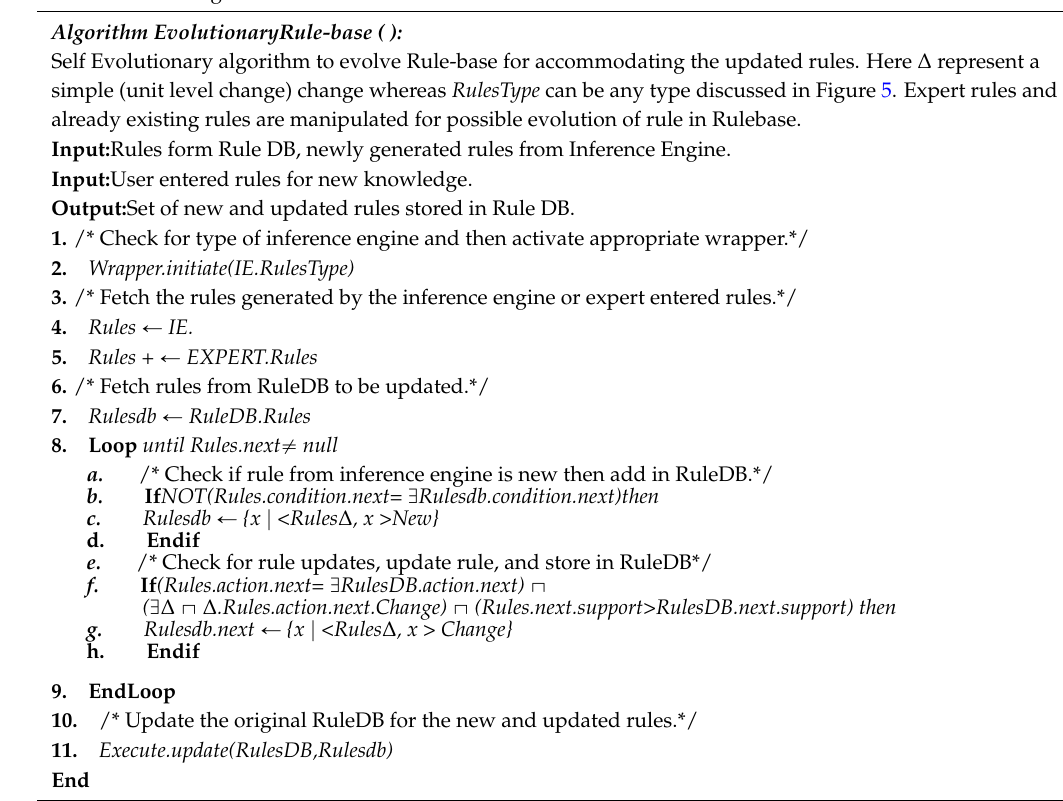
Algorithm 3. A Self Evolutionary Rule-base algorithm for updates in Rule DB to accommodate the evolving domain